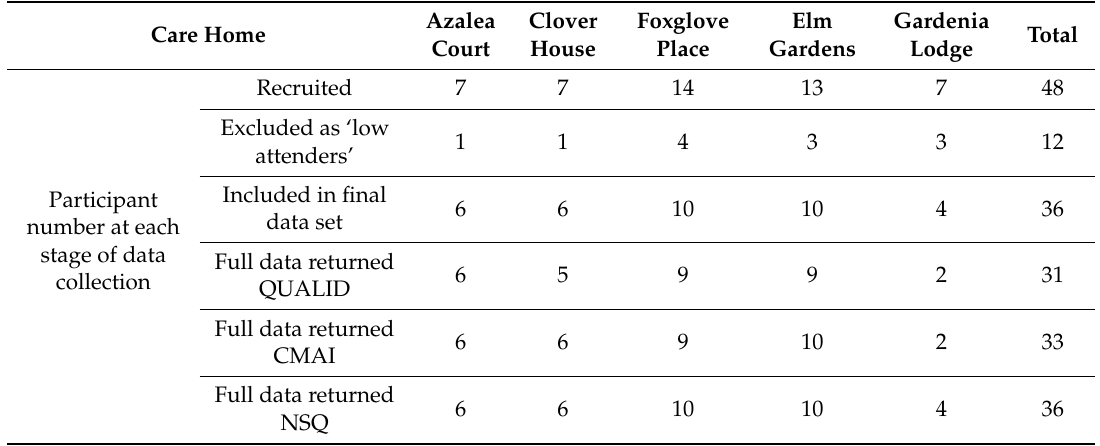
Table 5. Resident participant flow through the study.